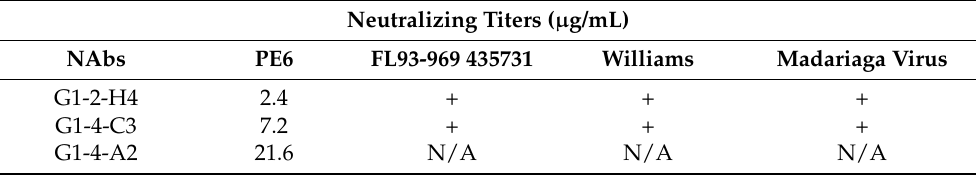
Table 1. Anti-EEEV NAbs.